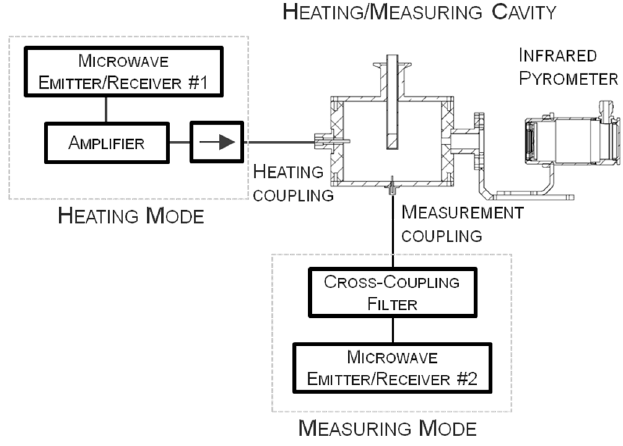
Figure 1. Schematic view of the equipment designed to determine microwave-matter